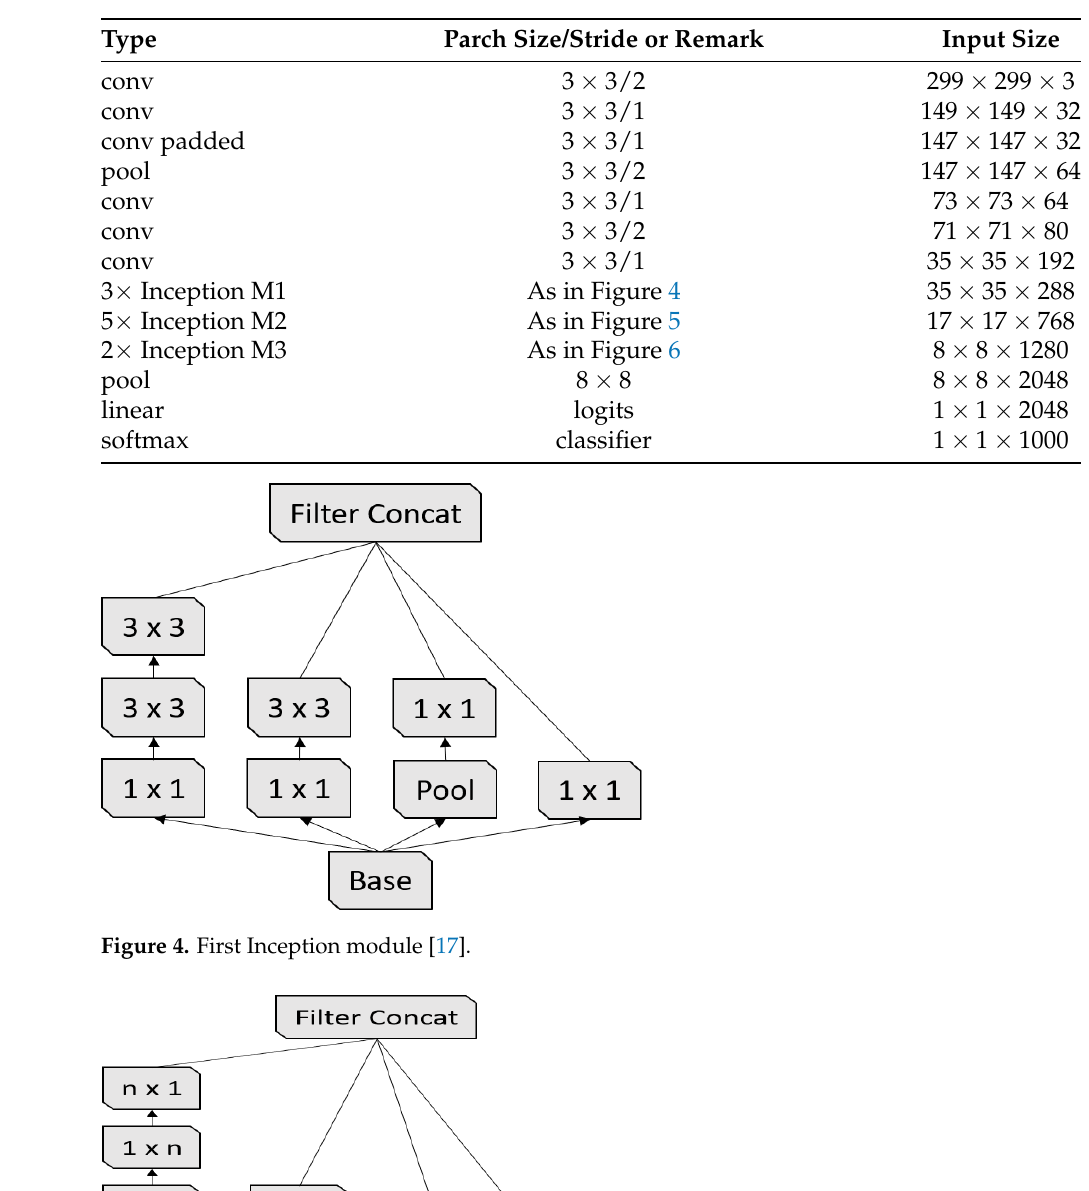
Table 5. Inception-v3 architecture [17].